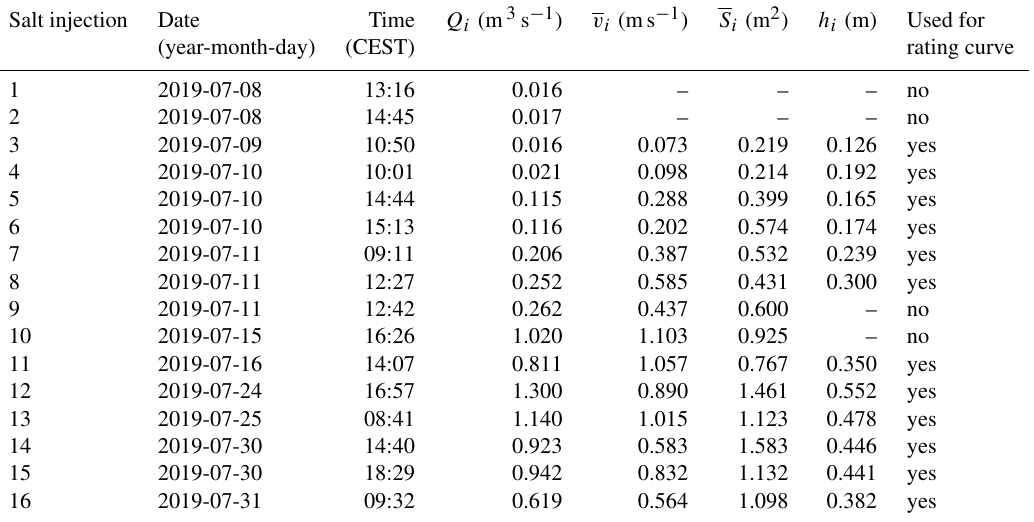
Table B1. Table of salt dilution experiments conducted to determine Q i at station P3 and to obtain v i and S i averaged between stations P5 and P3. Salt dilution experiments at P3 were used for the rating curve (Eq. 4) when water stage h i was available at the same moment and at the same location. The accuracy for Q i and S i is typically 4%. The accuracy for h i is